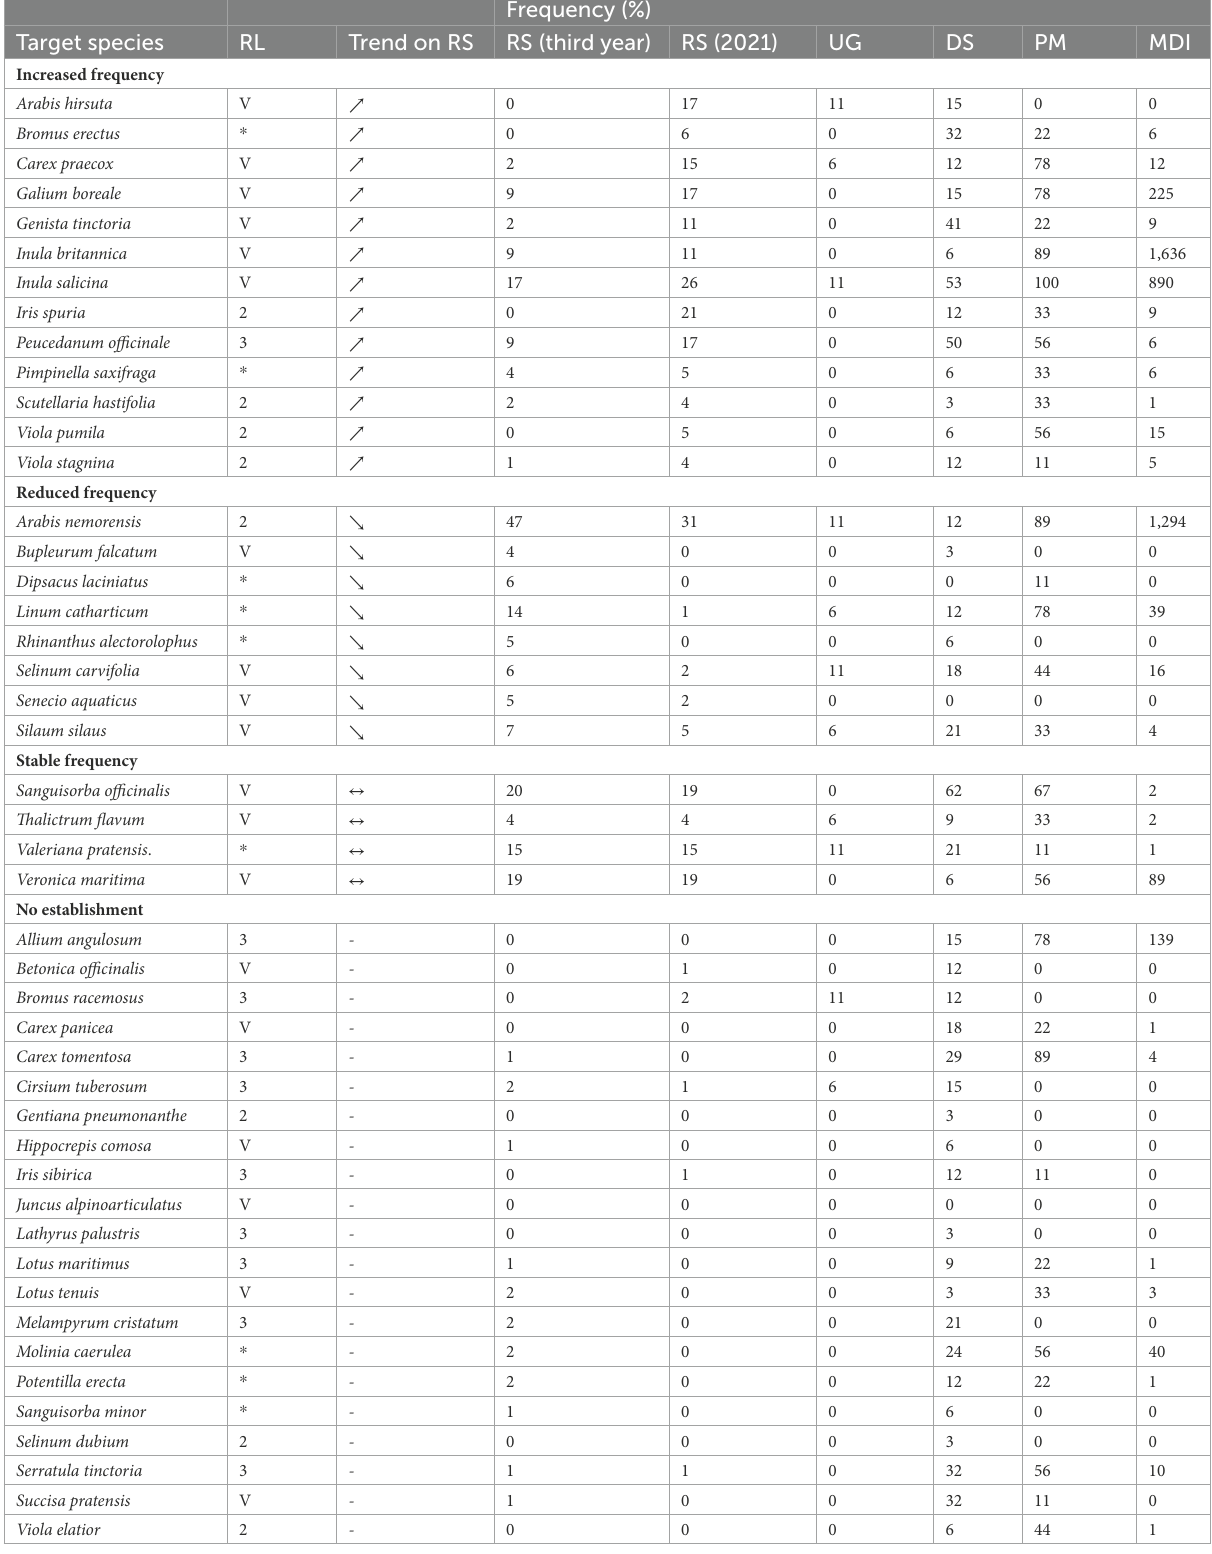
TABLE 1 Development of target species over time.